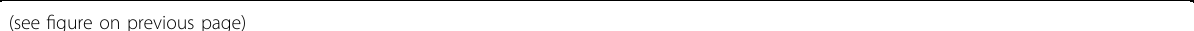
Fig. 1 CRISPR/Cas9-mediated CHD8 mutations in cynomolgus monkeys. a One-cell stage embryos of cynomolgus monkeys were injected with CHD8 gRNA and Cas9 mRNA. Embryos at 4 – 8-cell stage were transferred to surrogates to produce newborn monkeys with CHD8 mutations. b Schematic diagram of gRNA targeting exon 19 of CHD8 . Part of the CHD8 gene structure was shown, Protospacer-adjacent motif (PAM) sequence is highlighted in blue. gRNA targeting site is highlighted in red. c The numbers of transferred embryos, surrogates, and pregnancies for generating monkeys with CHD8 mutations. d Summary of generated monkeys carrying CHD8 mutations. e Examination of CHD8 mutations in monkey offspring by PCR and T7E1 cleavage assay. M DNA marker; WT wild type. Brain tissues of M1, M2, and WT control, embryos from T1, T2, and T3 and umbilical cord from M3 were analyzed. The upper panel shows PCR products and the low panel shows DNA products after T7E1 digestion. Stars indicate DNA mutations. f Sequences of mutated CHD8 alleles in monkey offspring. PAM sequence is highlighted in blue; gRNA targeting site in red. Mutation sequences are marked in green. Insertions ( + ) or deletions ( – ) are indicated within parentheses. The numbers of DNA clones showing mutations of the total number of examined clones are also included in parentheses. g Identi fi ed CHD8 mutations result in truncation of the CHD8 protein. Amino acid sequences in yellow are present in wild-type CHD8 whereas sequences in green are